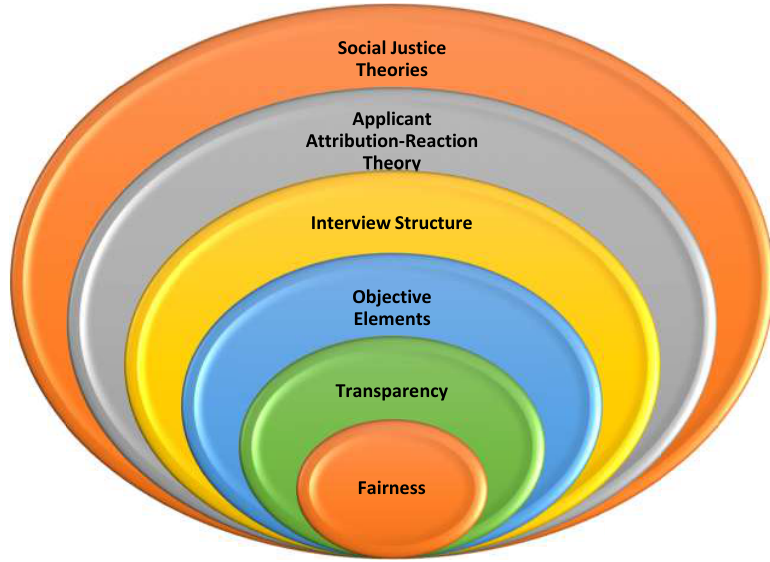
Figure 1. Applicant Attribution-Reaction Theory (AART) covering some major selection elements.